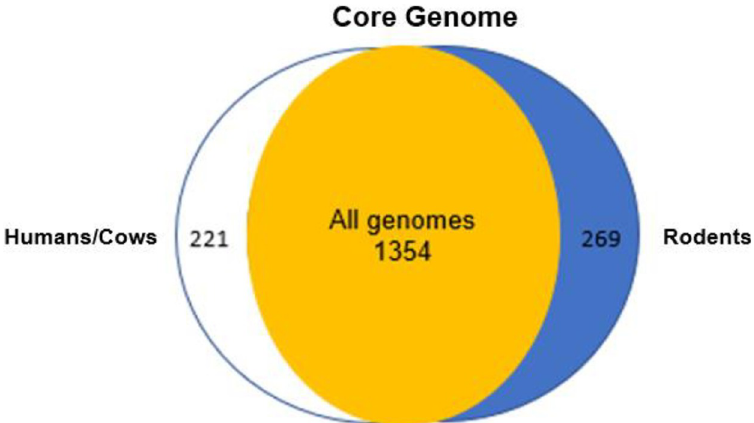
Fig 8. Venn diagram depicting the number of core genes in segregated groups of C . bovis isolates. All genomes, the number of genes composing the core genome of all 21 isolates; Humans/Cows, the number of genes of the core genome of the C . bovis isolates obtained from humans and cows, which were absent in one or more of the C . bovis isolates obtained from rodents; Rodents, the number of genes of the core genome of the C . bovis isolates obtained from mice and a rat, which were absent in one or more of the C . bovis isolates obtained from humans or cows.